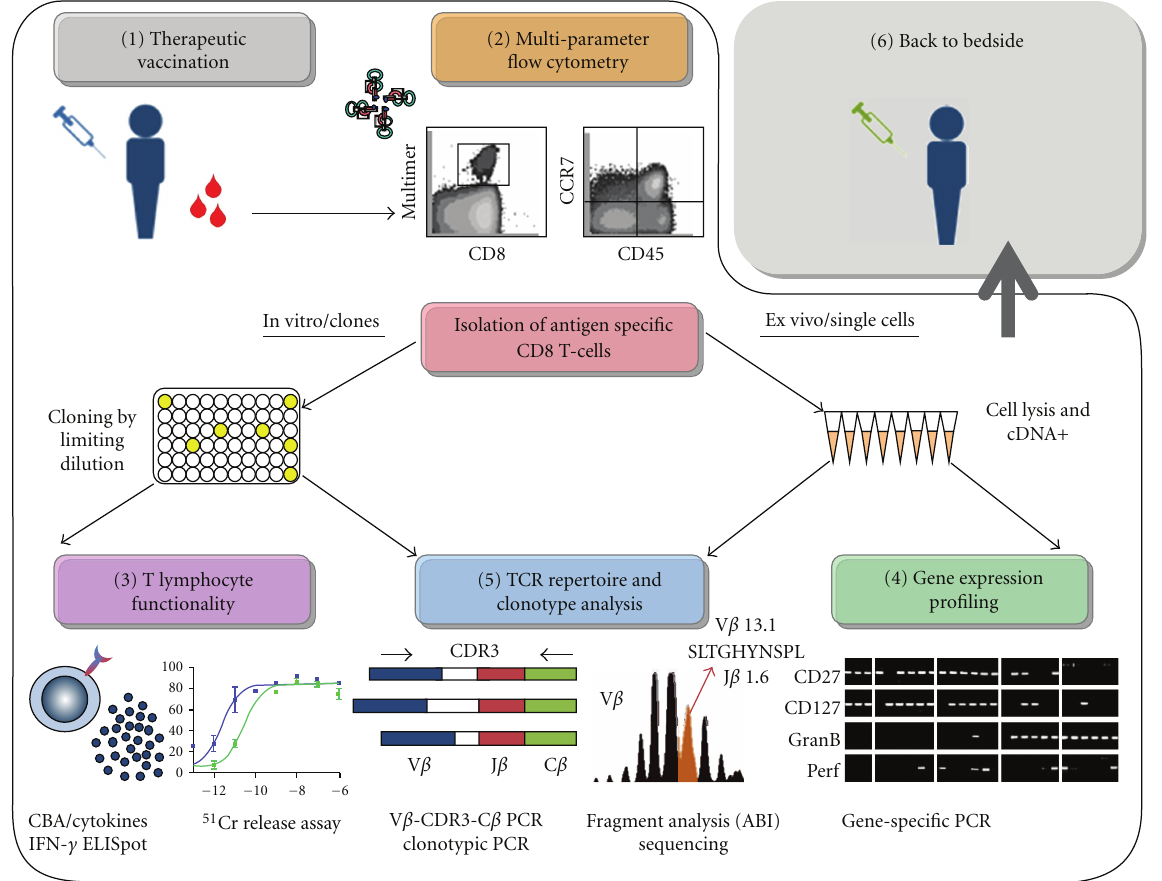
Figure 1: Cellular and molecular approaches for the characterization of cytotoxic T-cells following therapeutic vaccination. Each step (1